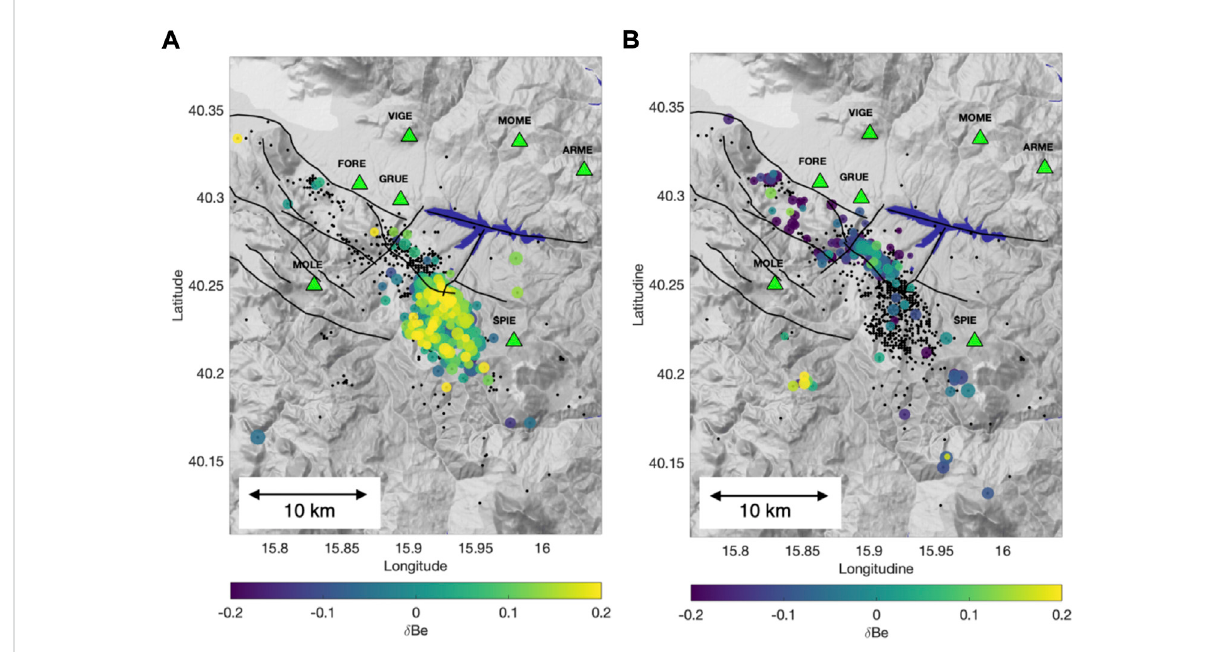
FIGURE 6 (A) Distribution of events for period # 1 (2003 – 2005), colored as per δ Be. (B) The same as (A) , but for period # 2 (2013 – 2015).